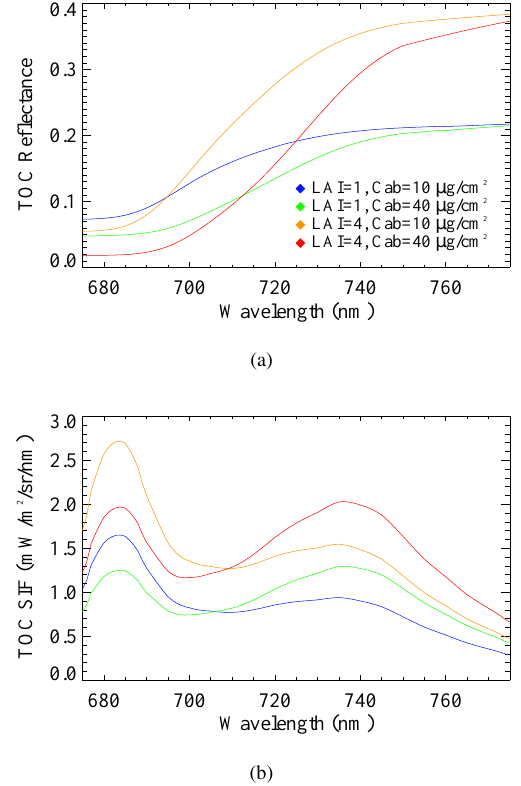
Figure 2. Top-of-canopy (TOC) surface reflectance (a) and SIF (b) Fig. 2: Top-of-canopy (TOC) surface reflectance (a) and SIF spectra as a function of leaf area index (LAI) and chlorophyll con- (b) spectra as a function of leaf-area index (LAI) and chloro- tent (Cab) in the 675–775nm spectral range covered by the NIR-A phyll content (Cab) in the 675–775 nm spectral range cov- and NIR-B spectral bands of ered by the NIR-A and NIR-B spectral bands of TROPOMI.